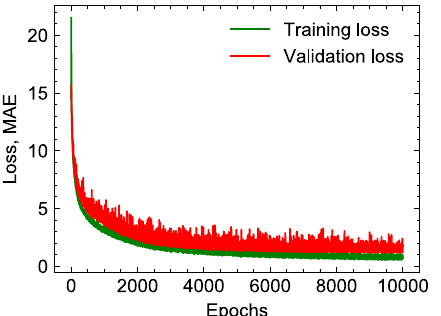
Figure 8. MAE loss function for training and validation datasets as a function of epochs.